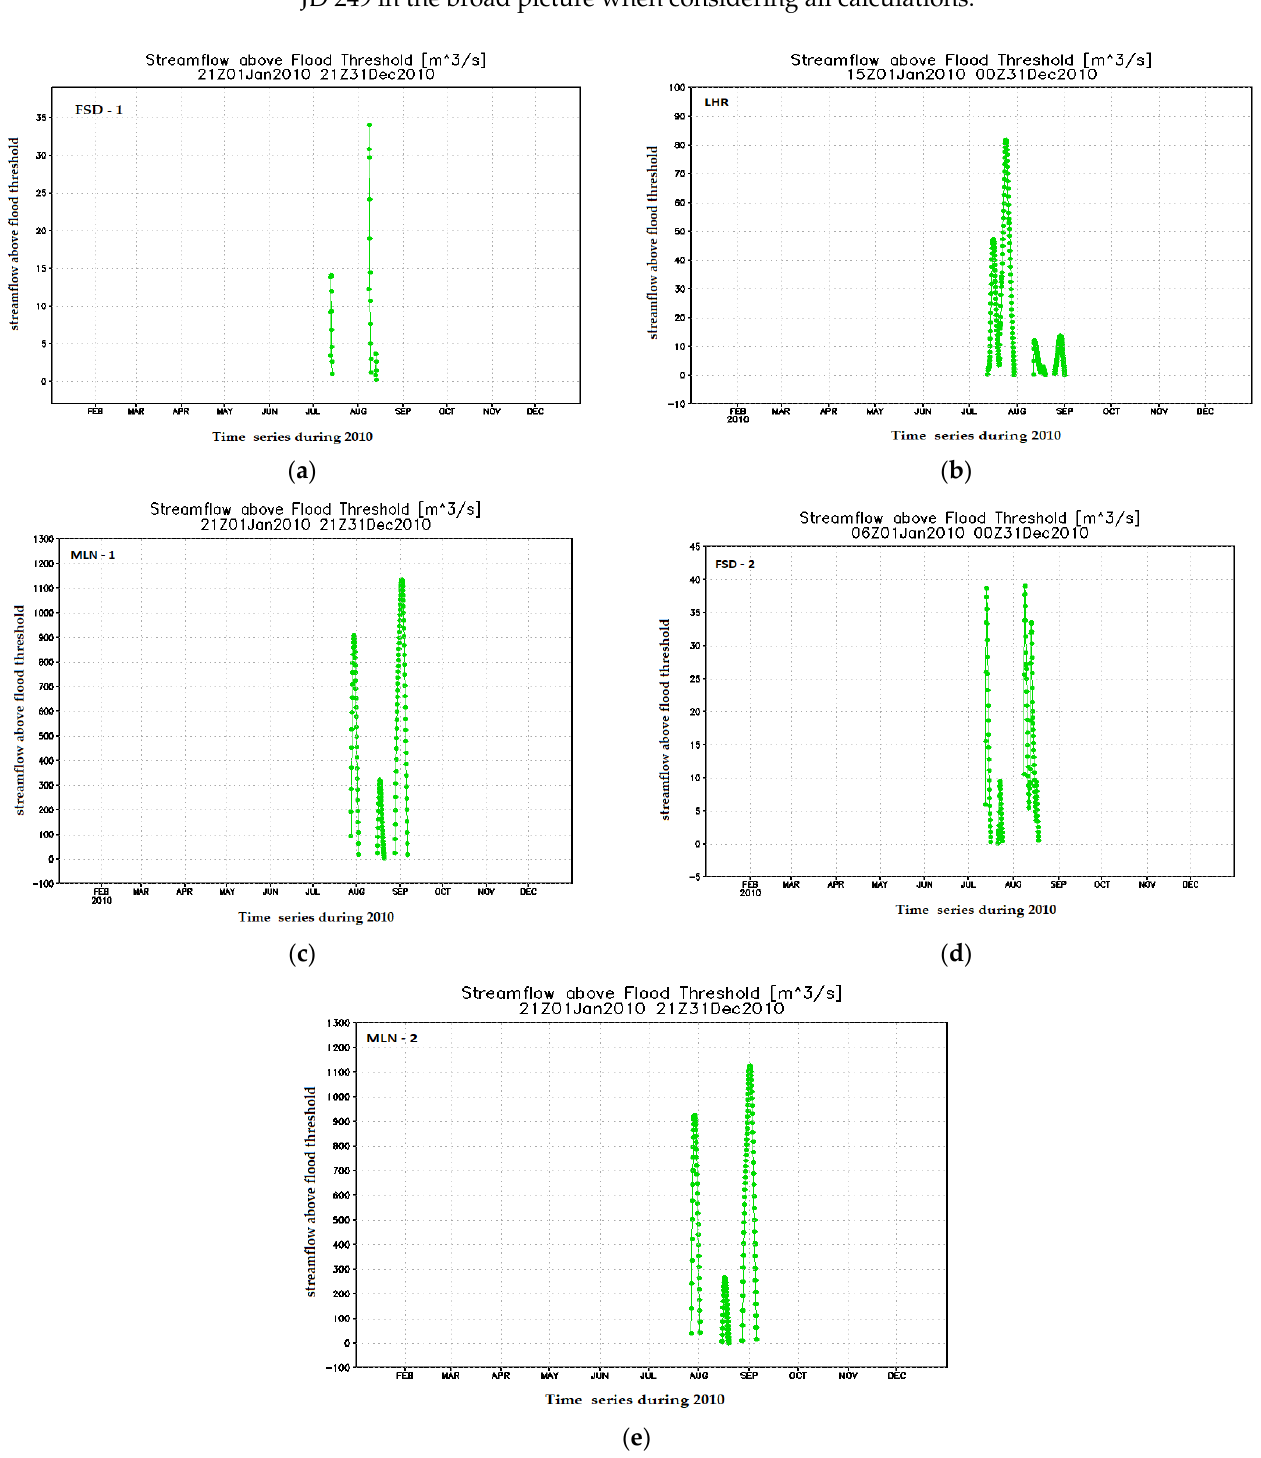
Figure 7. The monthly flood streamflow (above flood threshold) events time series at 3 h intervals over five weather stations (21Z01Jan2010 to 21Z31Dec2010): ( a ) FSD 1, ( d ) 2 FSD stations located in the south, ( b ) LHR located in the northeast, ( c ) MLN 1 in the center of the plain, and ( e ) MLN 2, also located in the center of the